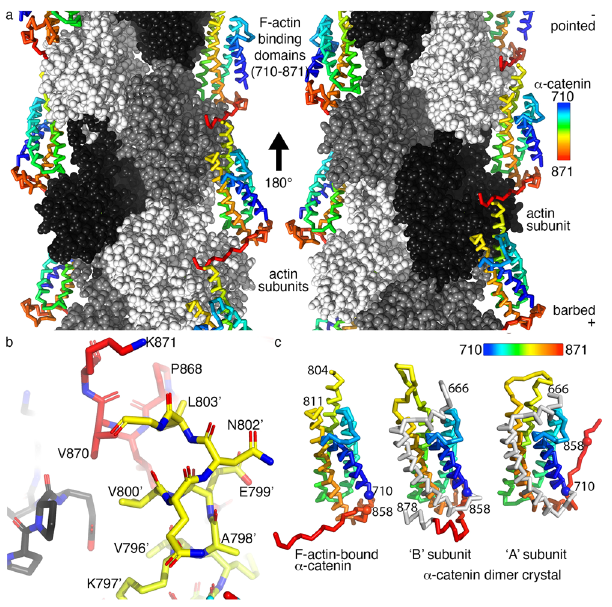
Fig. 3 The 2.8 Å cryoEM structure of dimeric α -catenin bound to F-actin. a C α trace of α -catenin, colored spectrally from shorter to longer wavelengths for residues 710 – 871 as indicated. Actin subunits are shown as white, gray, or black spheres. The left and right panels are views rotated 180° relative to each other as indicated. The F-actin barbed and pointed ends are indicated. b Close-up view of the α -catenin/ α -catenin interaction, colored spectrally. The distance from V870 to V800 ’ and L803 ’ is about 4 and 4.9 Å, respectively, while L869 with V796 ’ is about 3.9 Å. The prime indicates a residue on a separate α -catenin polypeptide chain. c C α trace of the α -catenin FABD bound to F-actin (left) compared to the FABD as seen in the two protomers in the unbound α -catenin dimer crystal structure (middle and right, respectively), shown in the same orientation. Terminal residues are labeled. Spheres are shown for the C α of residues 710 and 858 to highlight their different